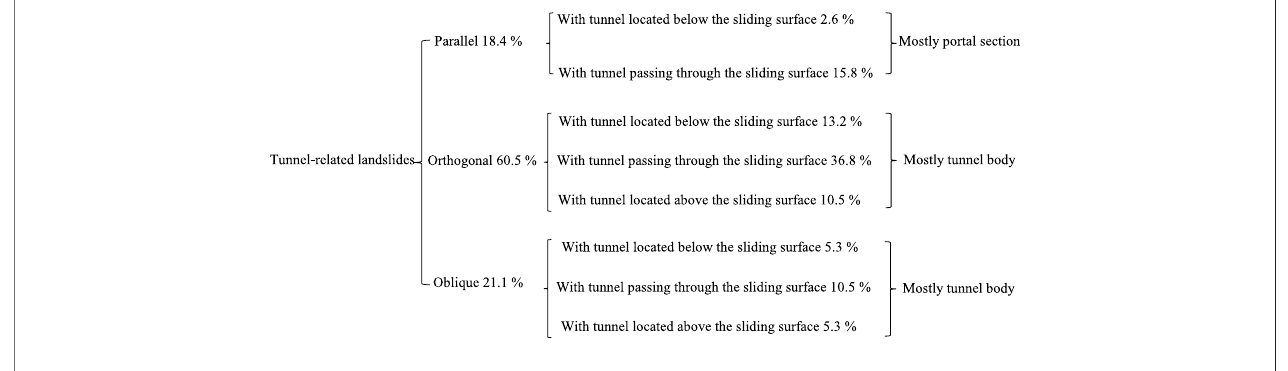
FIGURE 2 | Statistics of the tunnel-related landslides types.